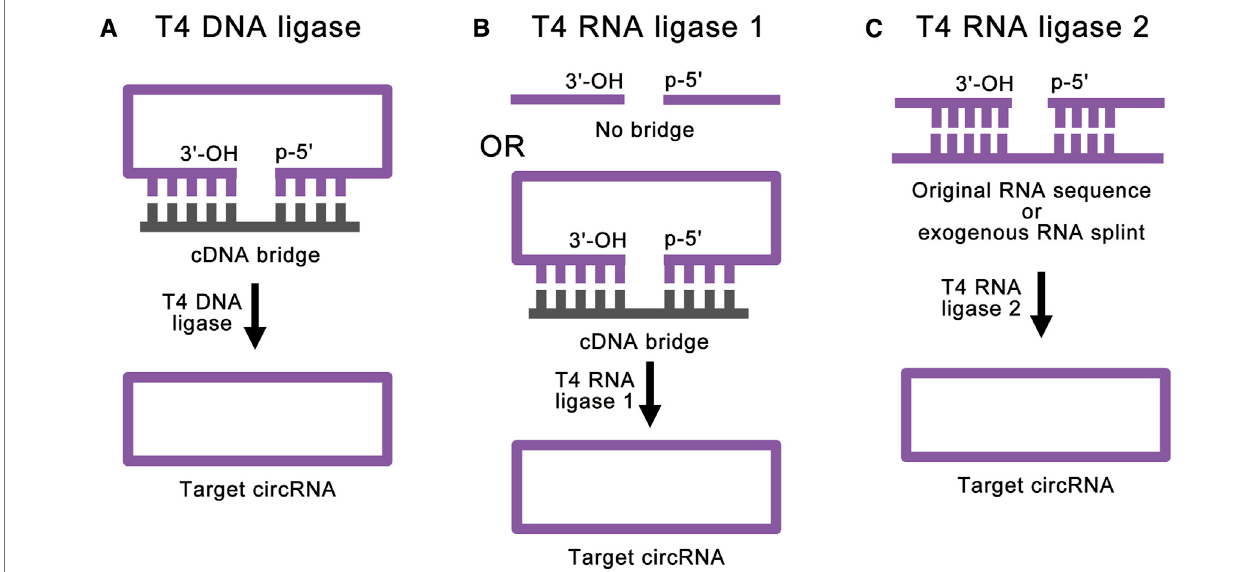
FIGURE 3 | Strategies for enzymatic ligations. (A) T4 DNA ligase can help ligate double-stranded duplexes, such as DNA/RNA hybrids. With the help of cDNA bridge, T4 DNA ligase can achieve accurate RNA ligation. (B) T4 RNA ligase 1 catalyzes the nucleophilic attack of the 3 ′ -OH terminus onto the activated 5 ′ -terminus to form a covalent 5 ′ , 3 ′ -phosphodiester bond. The cDNA bridge can prevent the linear RNA precursor from folding into an unsuitable structure. (C) T4 RNA ligase 2 is suitable for linear RNA precursor with the ligation junction in a double-stranded region. With the help of RNA splint, T4 RNA ligase 2 can also realize the ligation of ends of